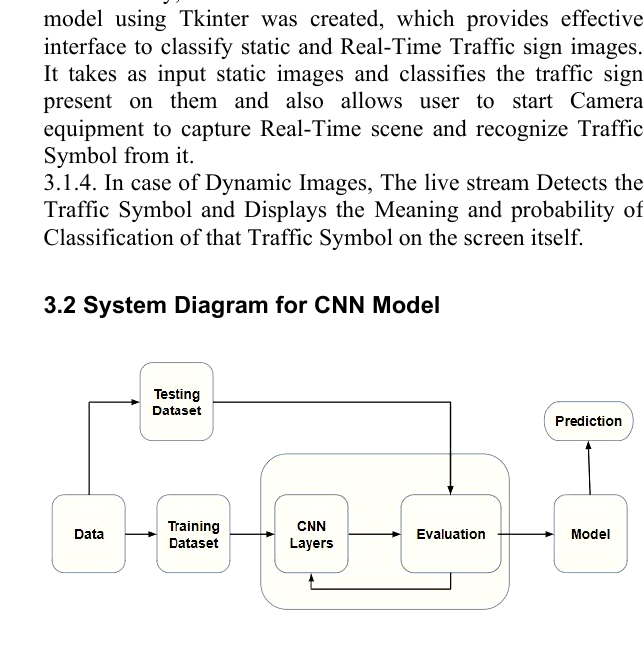
Fig. 2. System Diagram of CNN